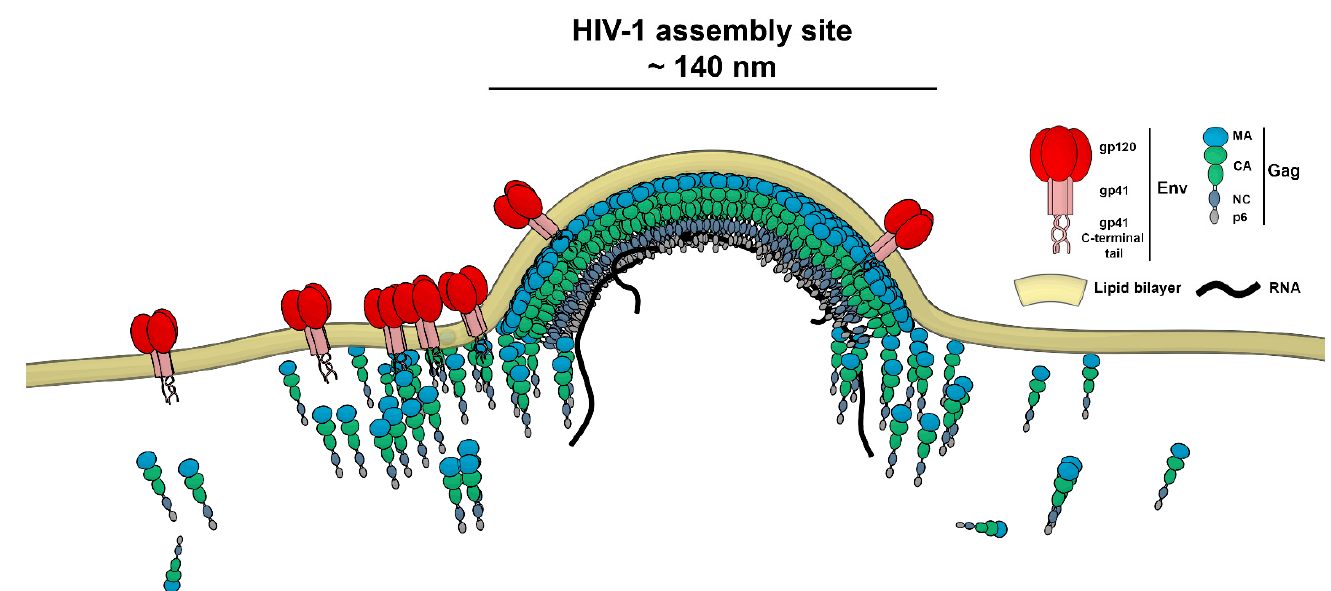
Figure 1. Schematic illustration of Gag and Env distribution during HIV-1 assembly on the cell plasma membrane.